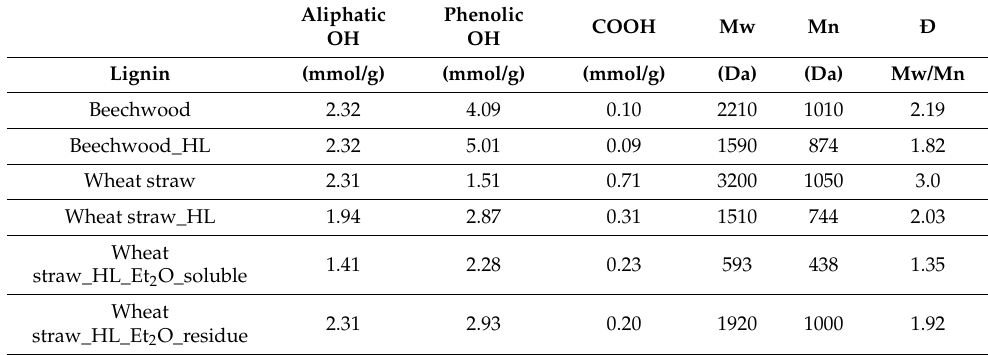
Table 2. Structural characterization of the different lignin fractions by 31 P-NMR.